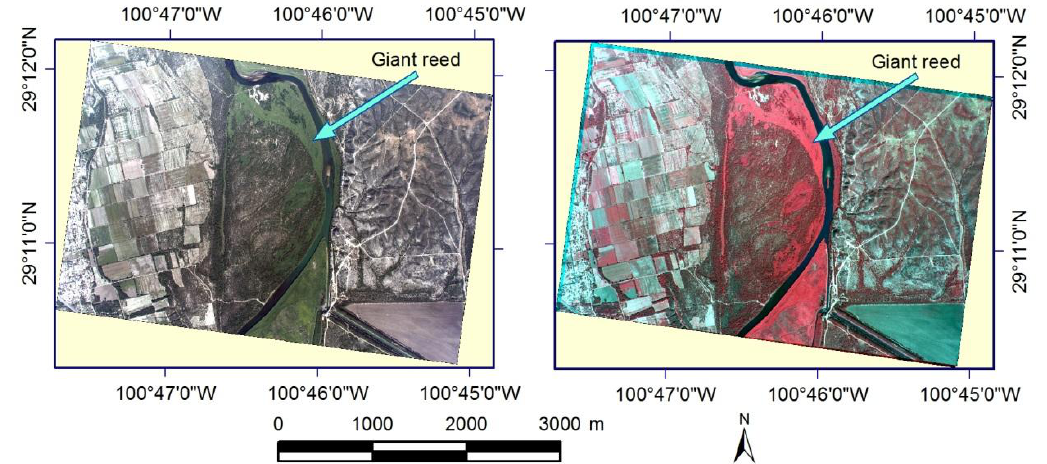
Figure 11. Normal color ( left ) and color-infrared ( right ) images acquired at 2438 m (8000 ft) above ground level on 15 November 2013 from a giant reed-infested area along the Rio Grande near Del Rio, Texas. Giant reed shows a lime green tone on the normal color image and a bright red color on the color-infrared